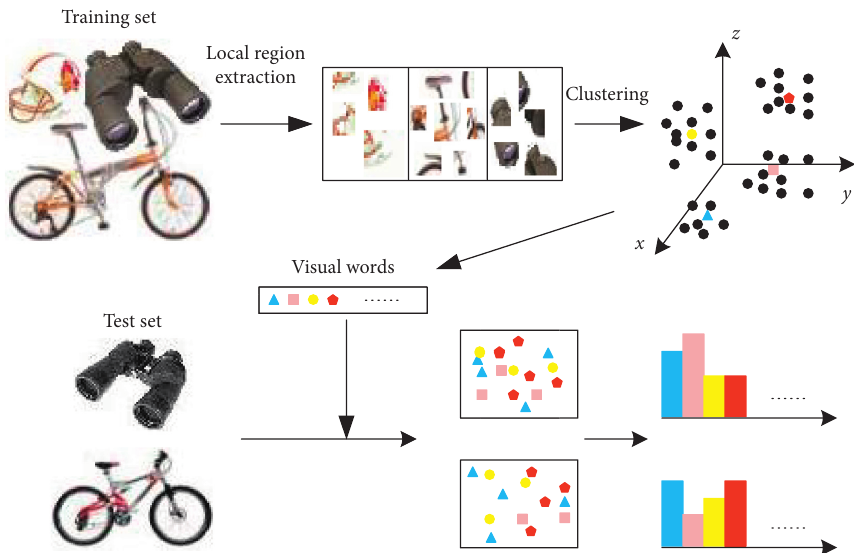
Figure 1: Schematic diagram of